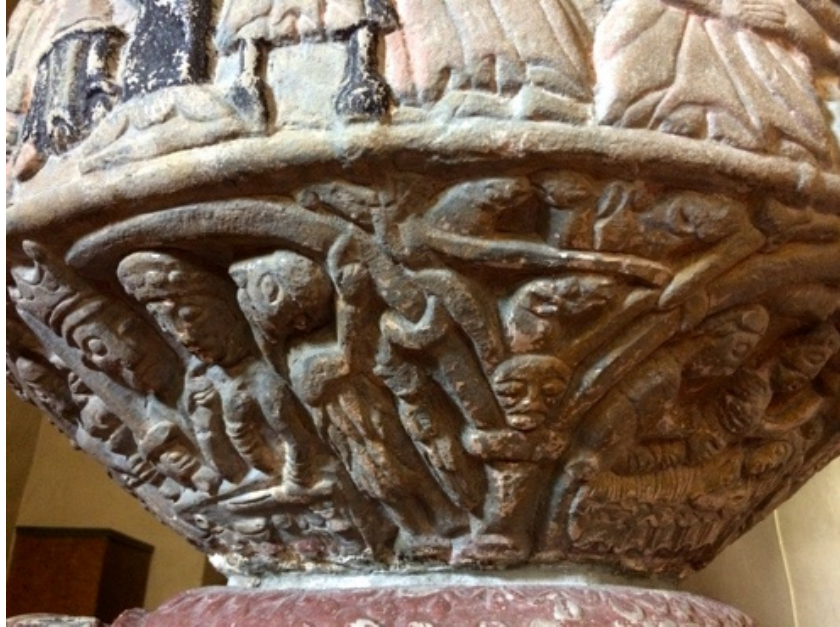
Figure 10. Font at Vänge, Gotland, described in a poem by Tomas Tranströmer (see note 39). It seemed to me that the drawing away of the last row of benches, of the piers of the arcade and the walls of the church were evidence of a centrifugal force exerted on the west part of the nave. If centrifugal, however, the force was equally centripetal, in the way that all things were invariably pulled into its orbit, in reference and relation, remoteness and nearness thus simultaneously gained.